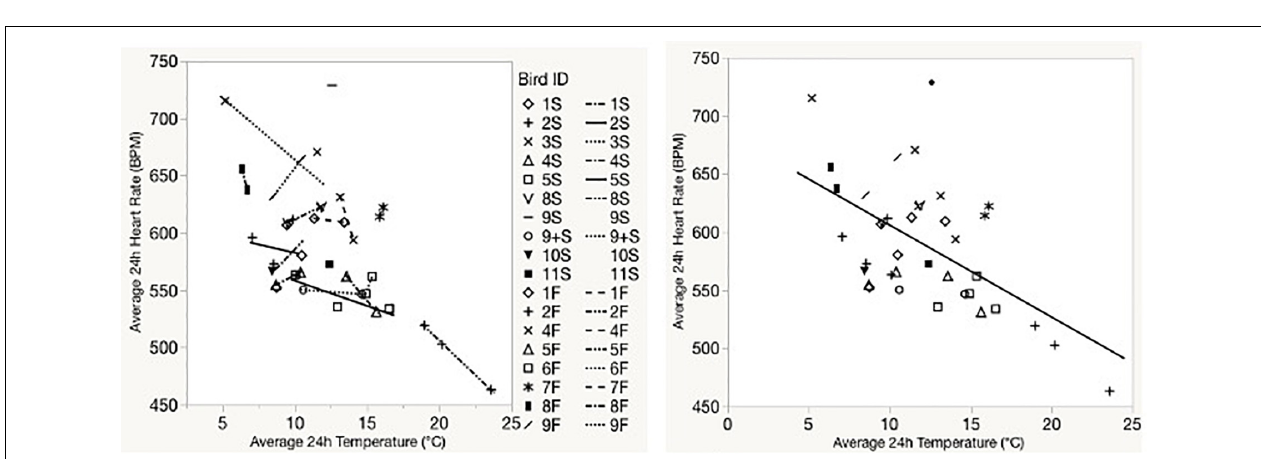
FIGURE 3 | Standard regression lines showing relationships between 24-h average heart rate and temperature for individual birds (left) and for all birds (right) in captive experiments.